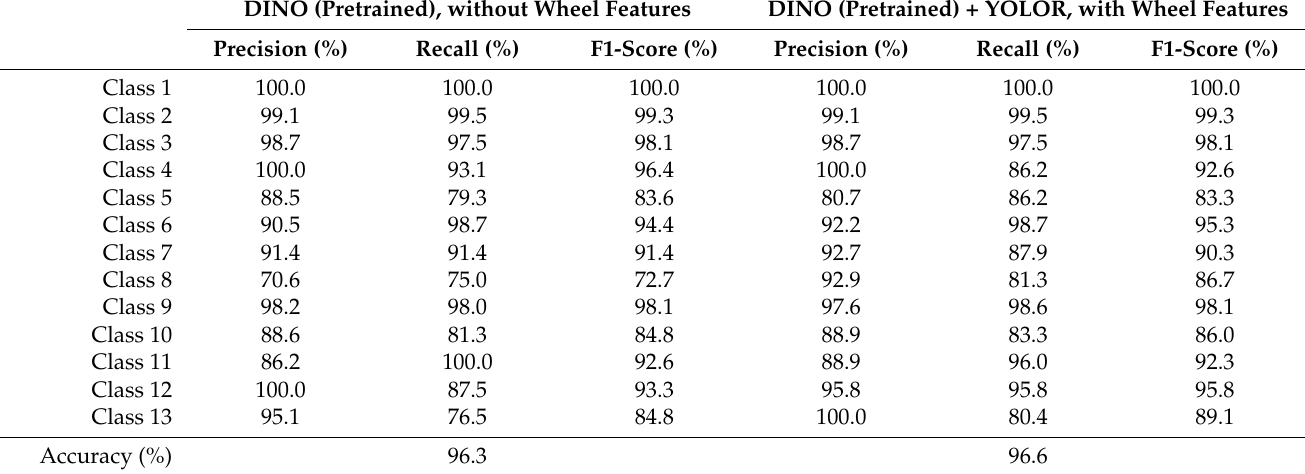
Table 5. Comparison of classification reports of the pretrained model (ViT + DINO) with and without wheel